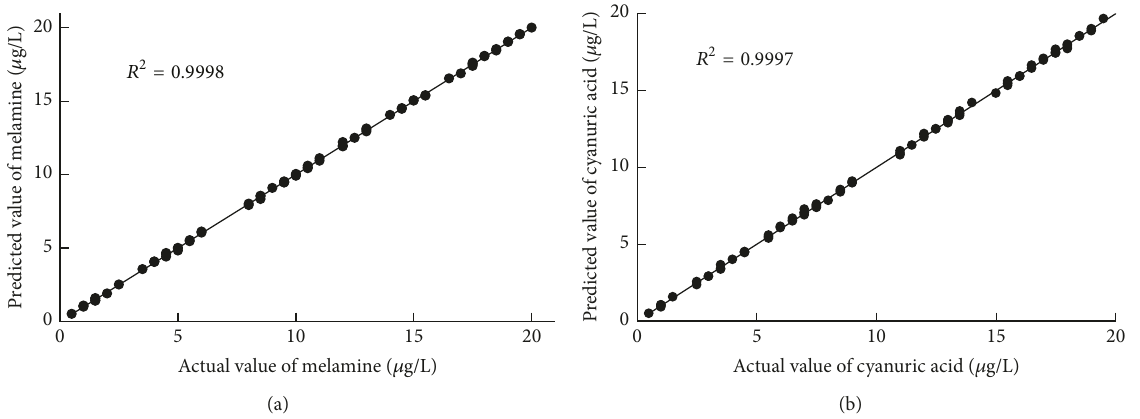
Figure 3: Plots of predicted values versus actual values of infant formula powder with (a) melamine and (b) cyanuric acid of calibration samples determined by the PLS1 algorithm.